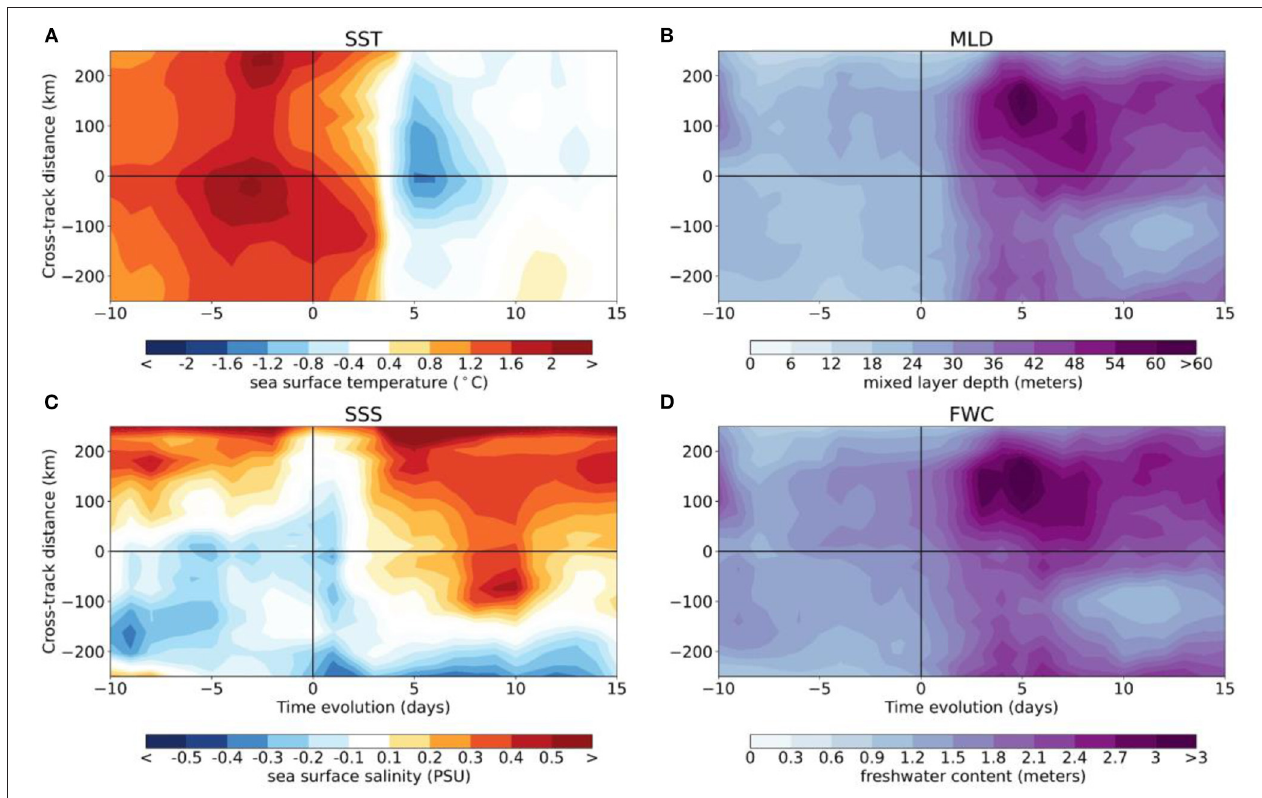
FIGURE 5 | Time evolution of cross cyclone track distribution of (A) sea surface temperature anomaly ( ◦ C), (B) mixed layer depth (m), (C) sea surface salinity anomaly (psu), and (D) freshwater content (m). Here negative (positive) y-axis represents left (right) side of the cyclone track, and negative (positive) x-axis represents days before (after) the